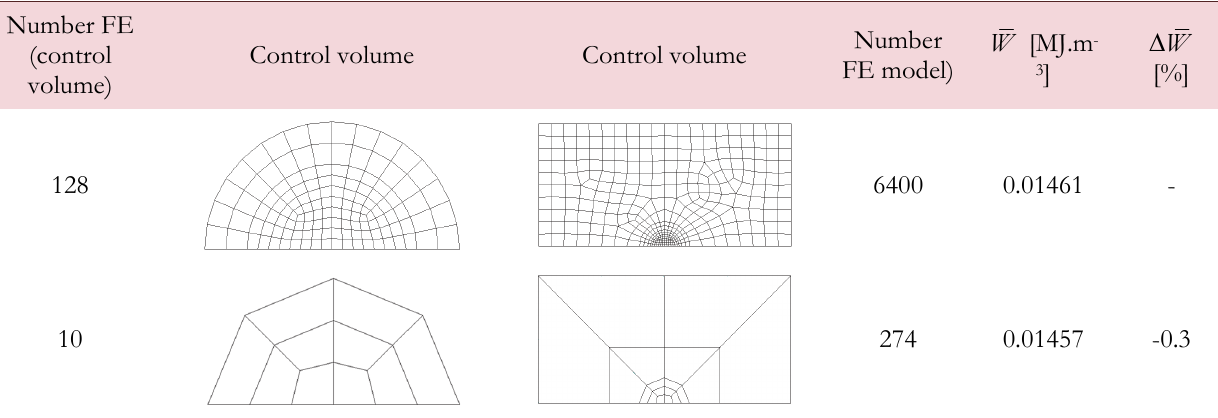
Table 1: Mean values of SED for different mesh refinement.